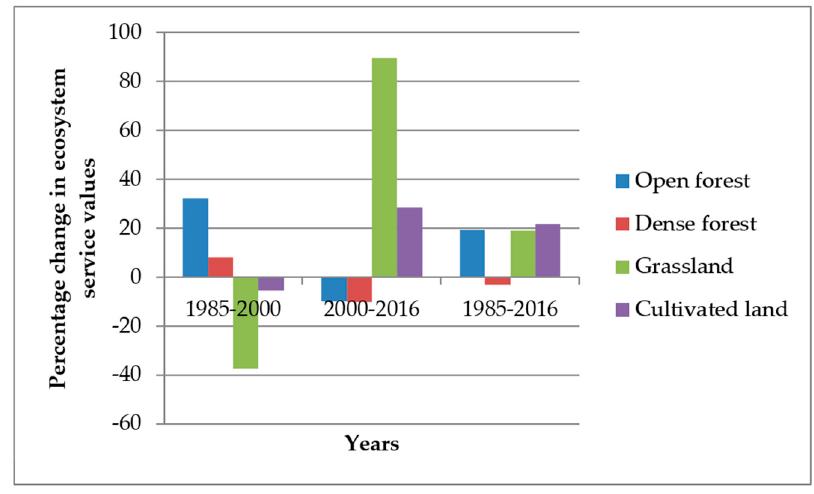
Figure 4. Changes in ecosystem service values between the reference years.